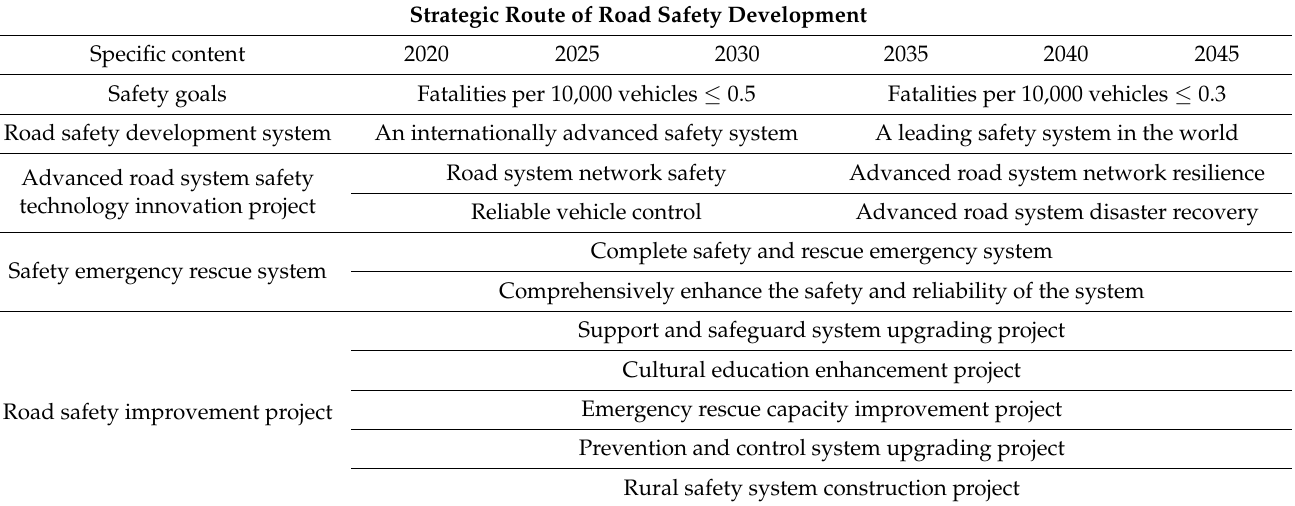
Table 2. Strategic route of road